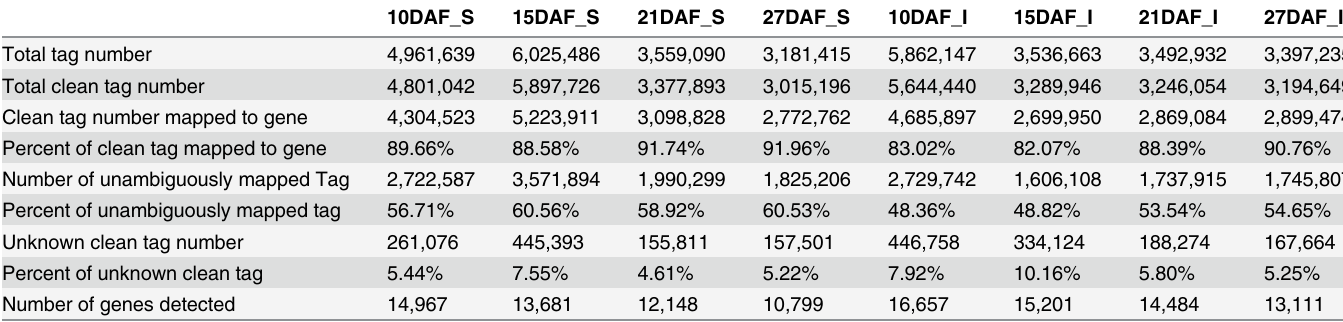
Table 1. Summary of sequencing and annotation results in the four filling stages of superior and inferior